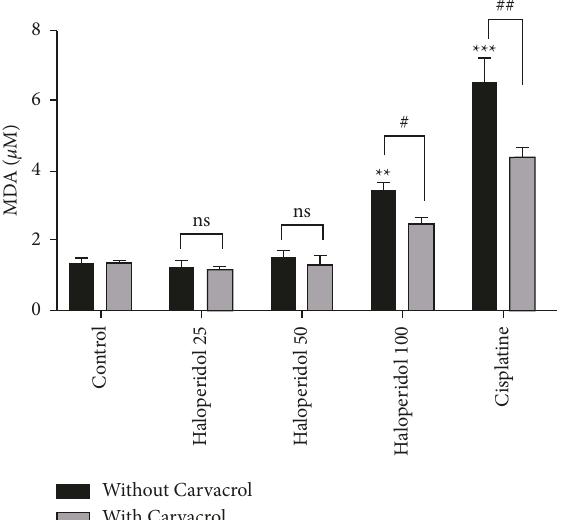
Figure 6: The protective effect of carvacrol on haloperidol-induced lipid peroxidation in human lymphocytes; MDA concentrations were evaluated as by-product of lipid peroxidation; values are presented as the mean ± SD; ∗∗ significantly different compared to the control group without carvacrol ( P < 0 . 01); ∗∗∗ significantly different compared to the control group without carvacrol ( P < 0 . 001); #significantly different in comparison with the halo- peridol-treated group without carvacrol ( P < 0 . 05 ); ##significantly different in comparison with the haloperidol- treated group without carvacrol ( P < 0 . 01); ns: not significant.